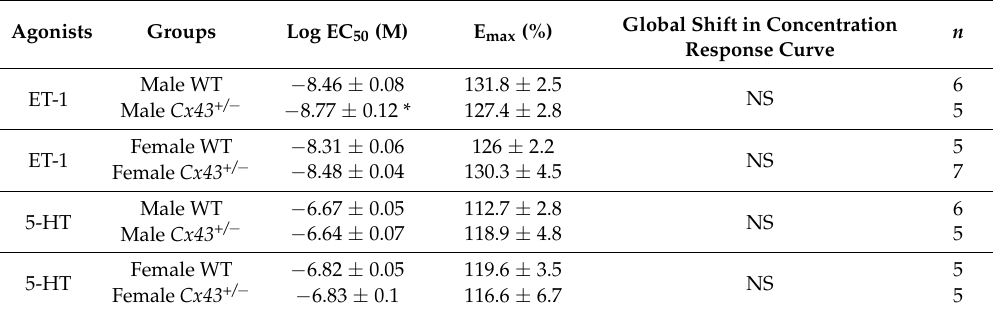
Log EC 50 indicates logarithm of median effective concentration. E max maximal contractile effect. Global differences in concentration response curves were compared by two-way ANOVA. Changes in logarithm of median effective concentration (Log EC 50 ) and maximal contractile responses (E max ) between two different groups were analyzed by the Student’s t -test. NS: not significant. * p < 0.05 compared to male WT mice. Data are shown as mean ± S.E.M.